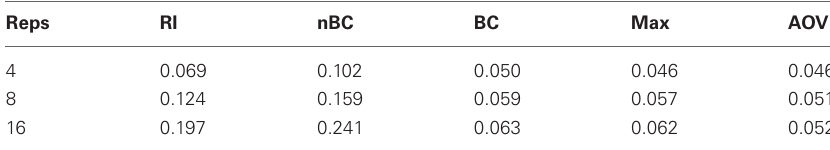
Table 3 | Type I error rate for test of ABC in 2 × 2 × 2 design.